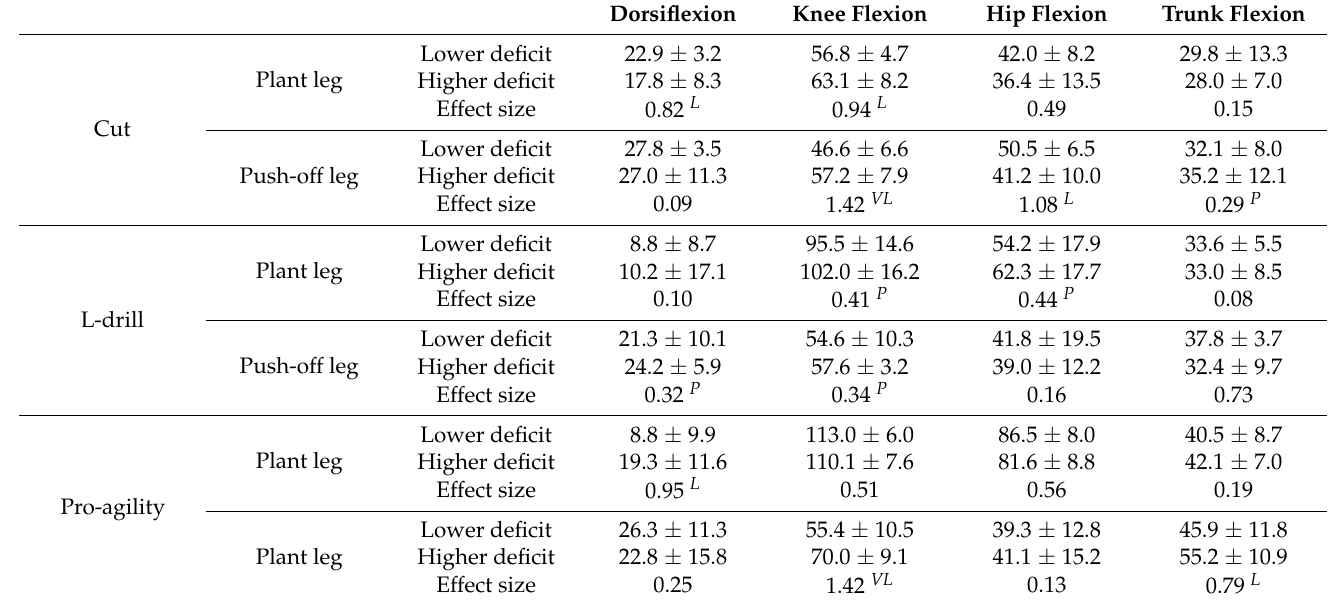
Table 8. Comparison of the joint angles between lower and higher COD deficit groups for the plant and push-off legs in the three distinct change of direction protocols performed. Dorsiflexion Knee Flexion Hip Flexion Trunk Flexion Plant Cut